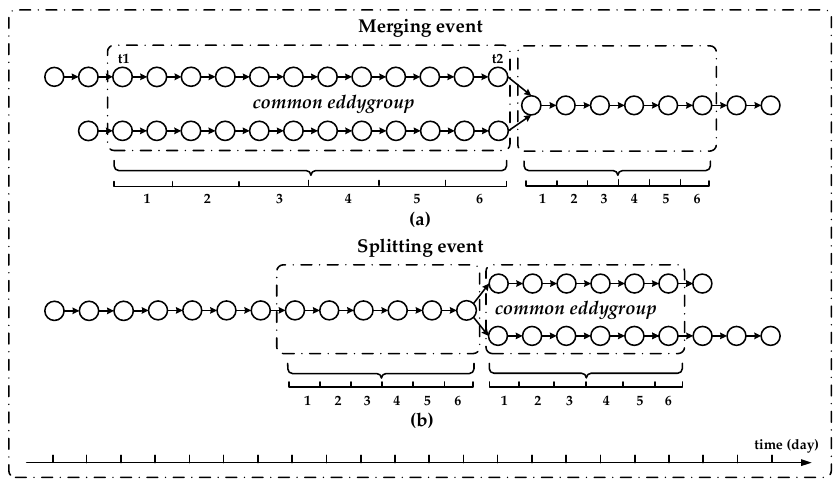
Figure 13. The temporal normalization of eddy merging and splitting events: in which ( a , b ) represent the source eddy/eddies and sink eddy/eddies of a merging event and a splitting event, respectively, being projected into different time periods.